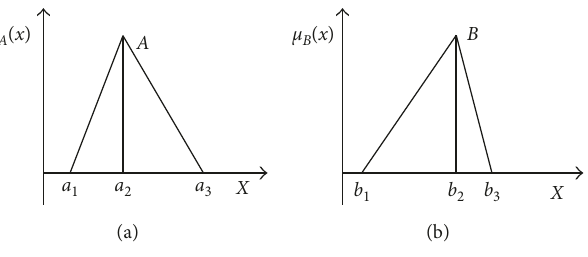
Figure 2: Z- number, Z � ( A, B ) . (a) Restriction; (b)